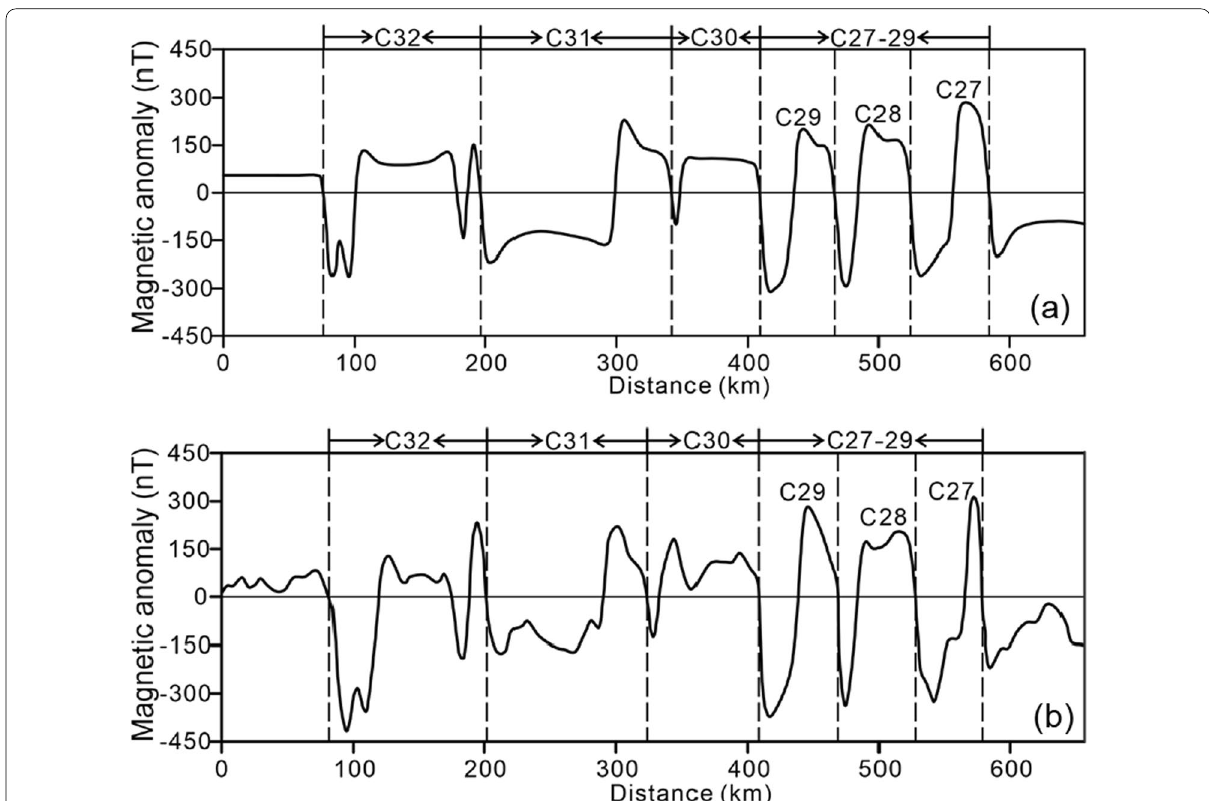
Fig. 14 The synthetic and observed marine magnetic anomalies of EL33 (From Cande 1976). a The synthetic marine magnetic anomalies of EL33. b The observed marine magnetic anomalies of EL33. Dashed lines show the boundaries of magnetic anomalies of different polarity